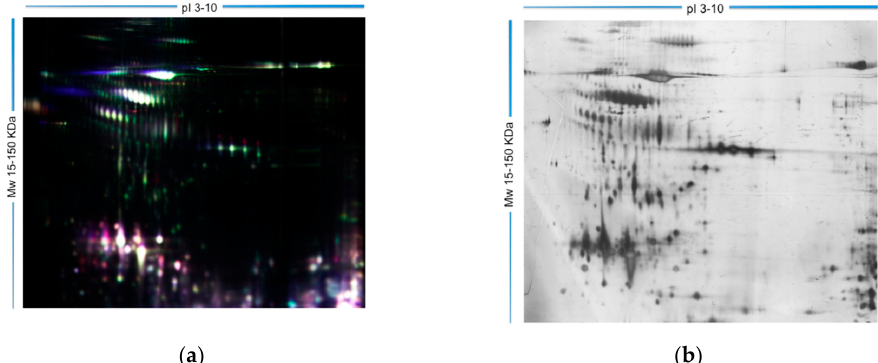
Figure 1. Distribution spots of differentially expressed proteins from seminal plasma samples among fertile and patients group. Representative image in fluorescence difference gel electrophoresis (DIGE) ( a ) and in silver stained ( b ).